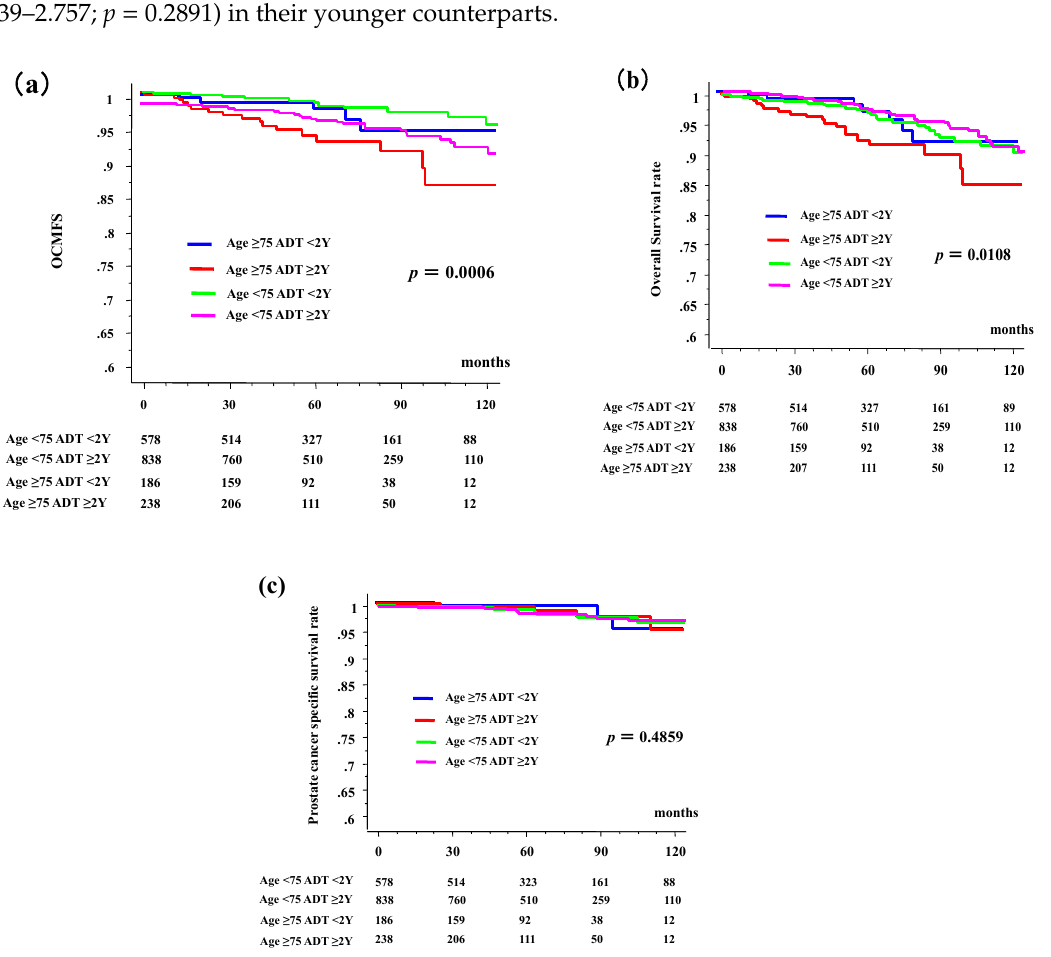
Table 4. Characteristics and treatment factors for OCM according to ADT duration.